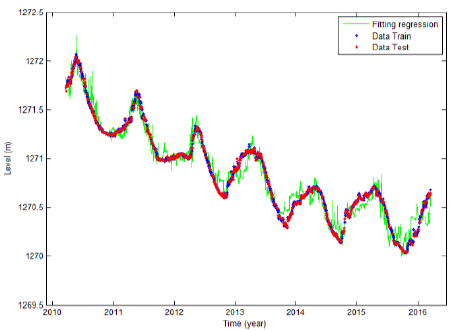
Figure 11: The regression graph of 3 rd degree of polynomial